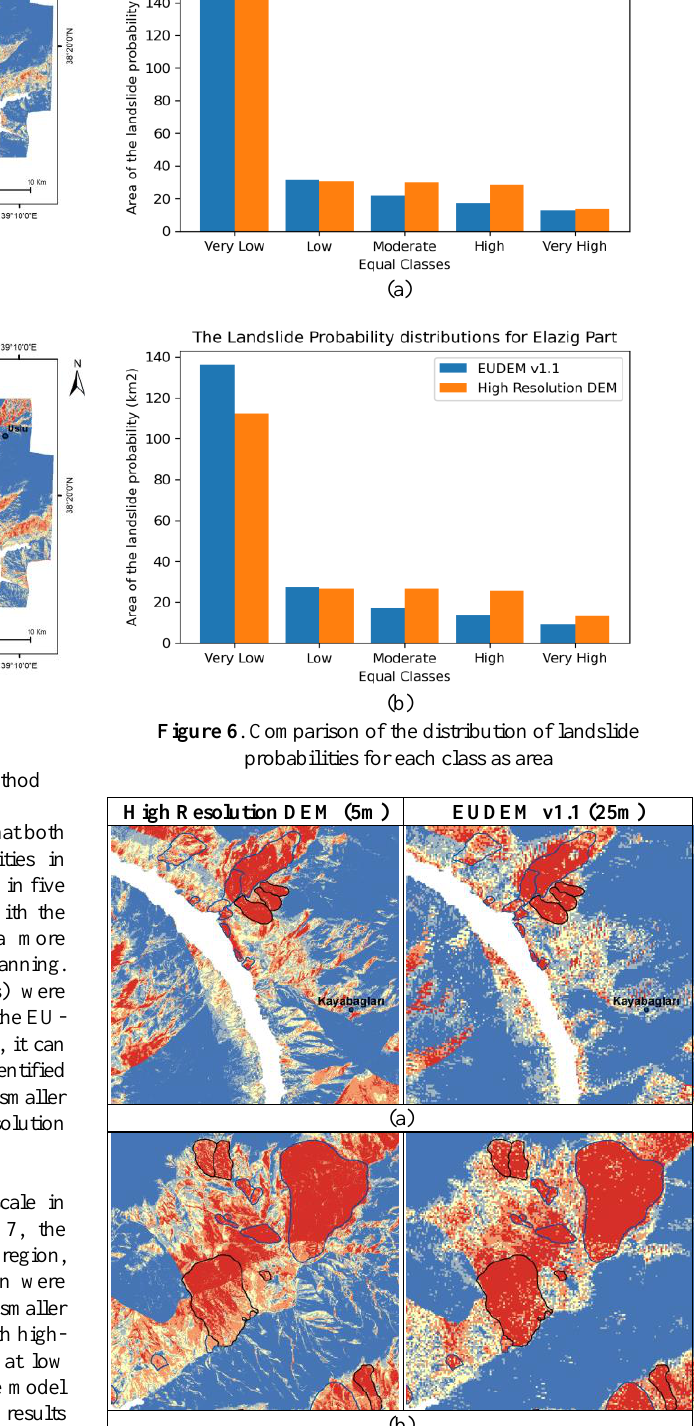
Figure 7 . Parts of the LSMs obtained using the aerial DEM (left) and EUDEM v1.1